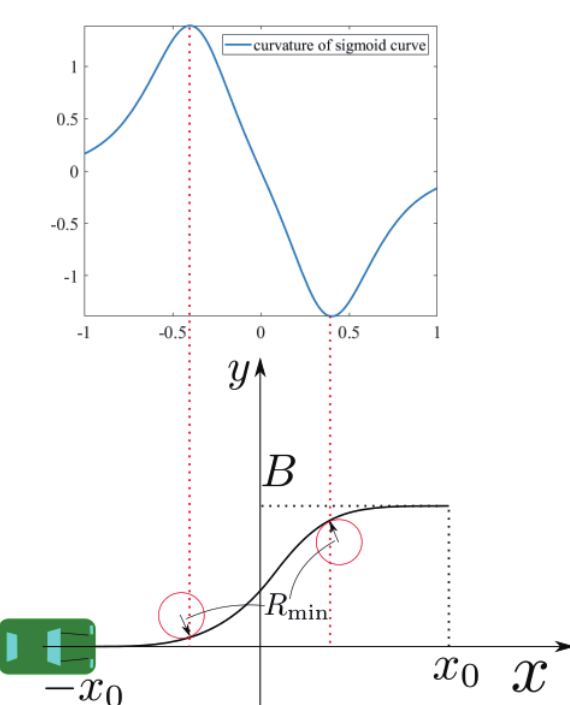
Figure 4. The parameters for the sigmoid curve under a = 5 and the location of the minimum curvature radius.